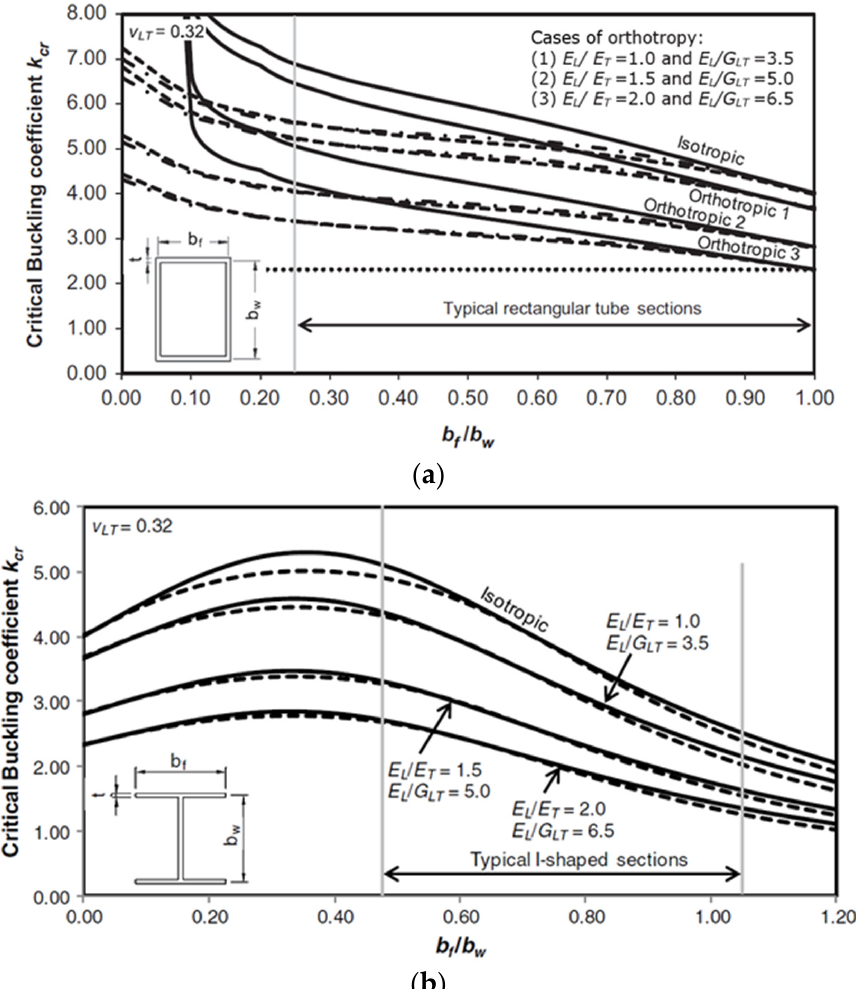
Figure 11. Buckling coefficient (k) versus b f /b w for different layup properties of ( a ) box [63] and ( b ) I-shape [64] GFRP columns.